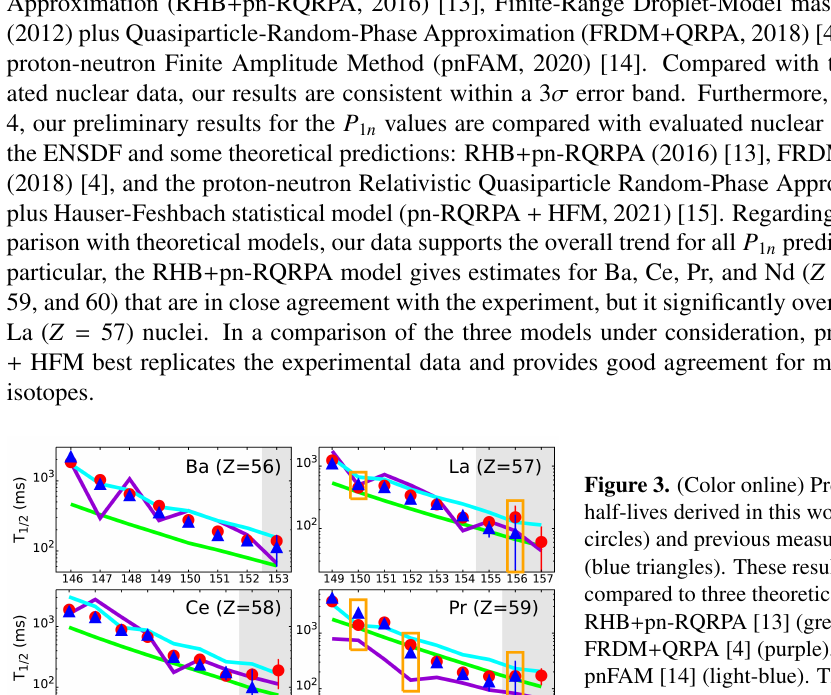
Figure 2. (Color online) Identification plot of the REP-BRIKEN 2018 experiment. Each red circumference corresponds to an identified isotope. The gray line represents the upper bound of the previously measured T 1 / 2 [11]. Yellow box highlights previously measured P 1 n values. The bottom panel depicts the projection of the PID matrix on the A / Q axis for the Pr ( Z = 59) isotopes.